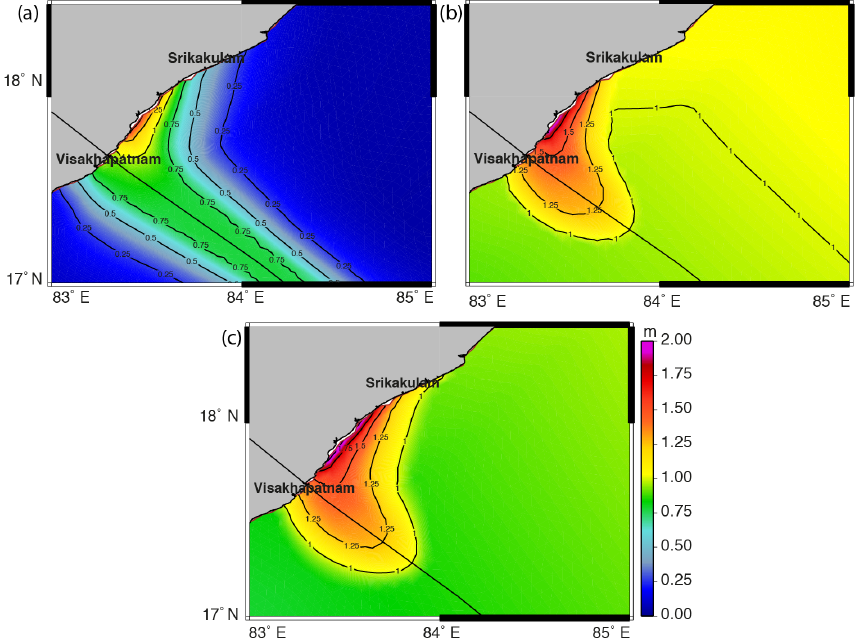
Figure 3. Spatial distribution of maximum surface elevation (metres) due to (a) cyclonic winds, (b) cyclonic winds and tides and (c) cyclonic winds, tides and waves (colour code represents surface elevation in metres).